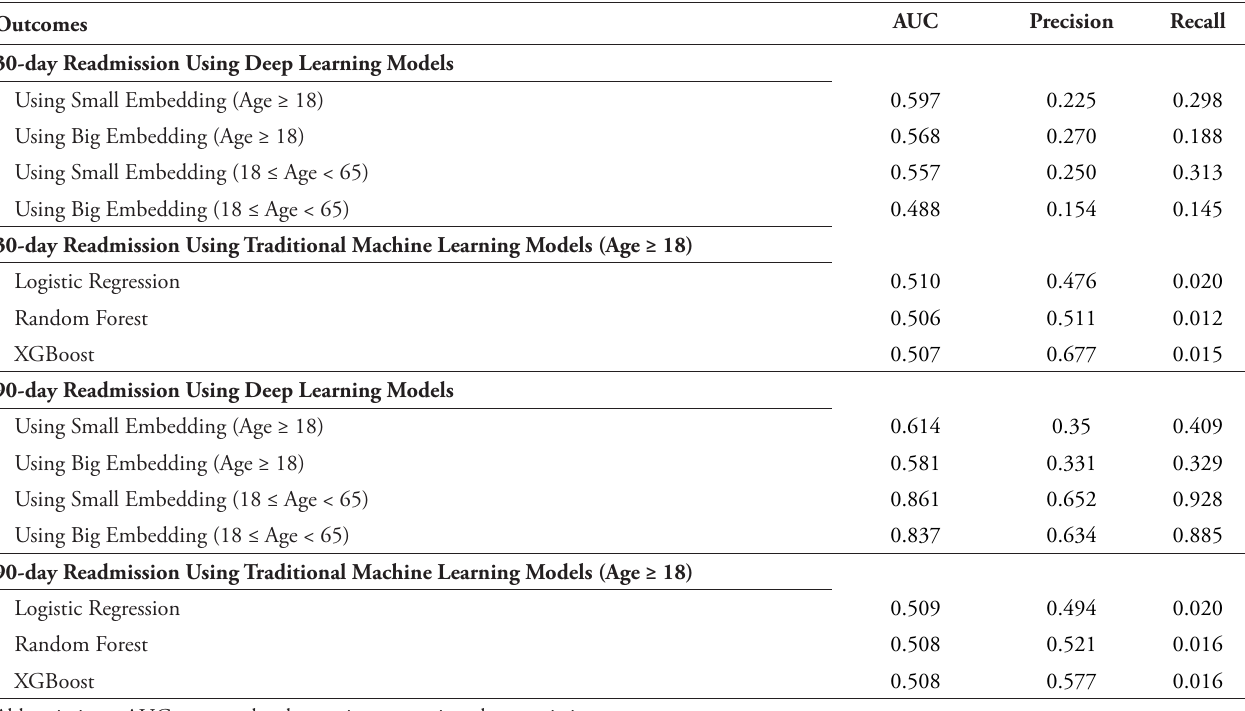
Table 4. Model Performance in Predicting 30-day and 90-day Readmissions Among Patients with Heart Failure with Reduced Ejection